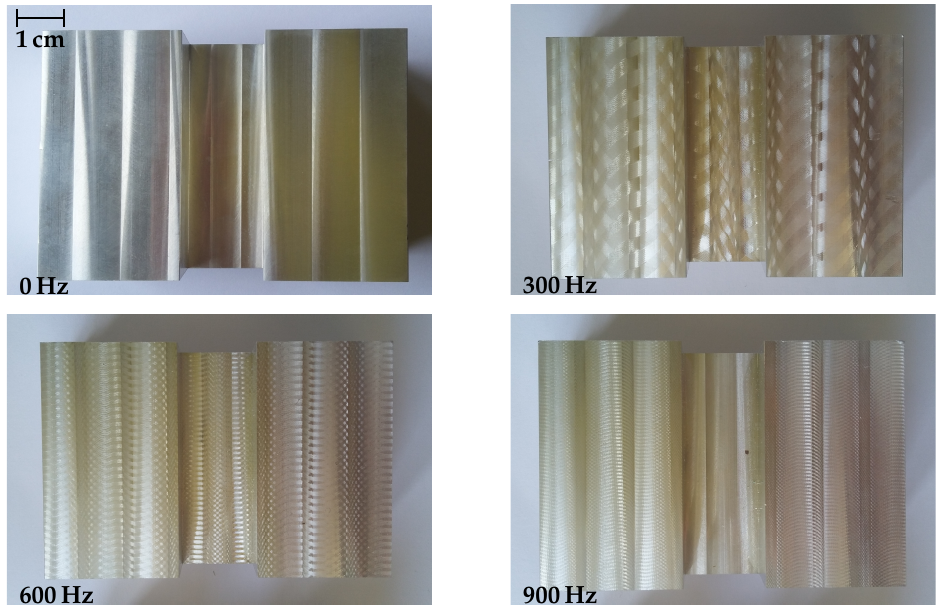
Figure 13. Photos of exemplary parts manufactured using the vibration assisted milling tool (material: aluminium alloy EN AW-6082; cutting parameters: spindle speed 3000rpm, feed 420mm/min, feed per tooth 105mm/min, cutting depth 0.5mm; tool: HSS PM